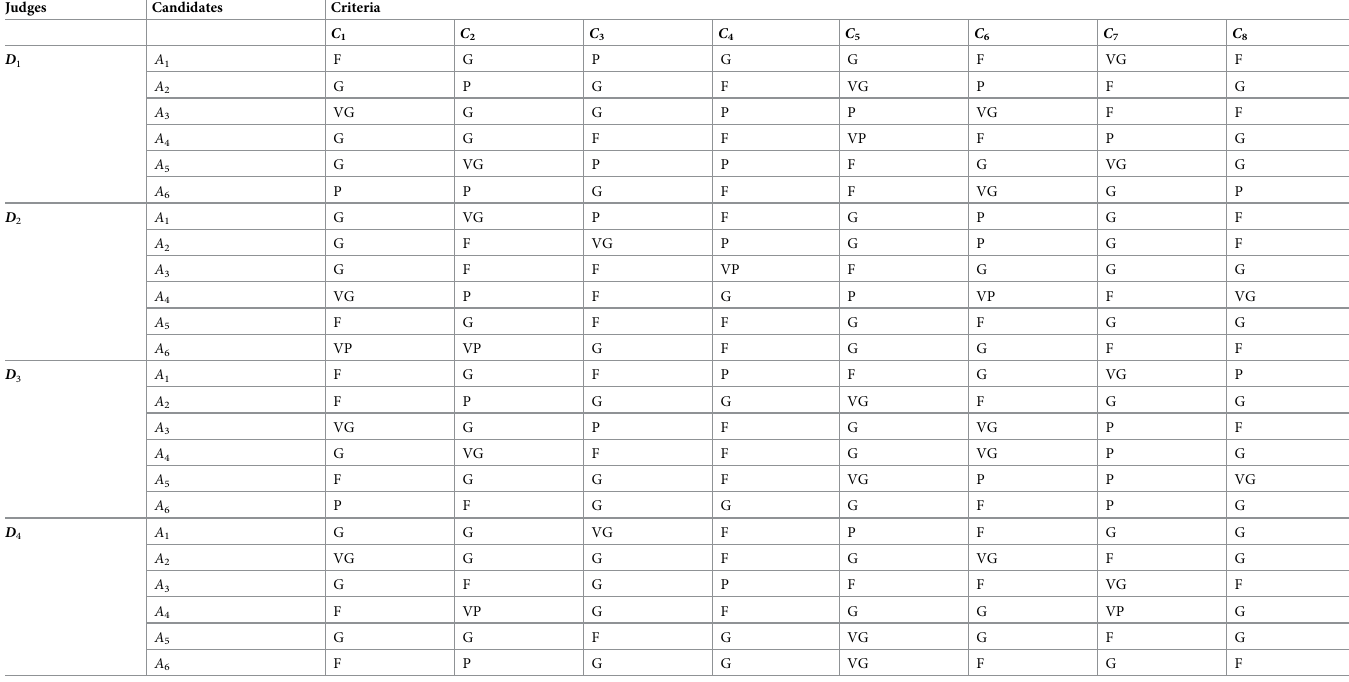
Table 8. Linguistic variables for rating of alternatives assessed by decision makers. Judges